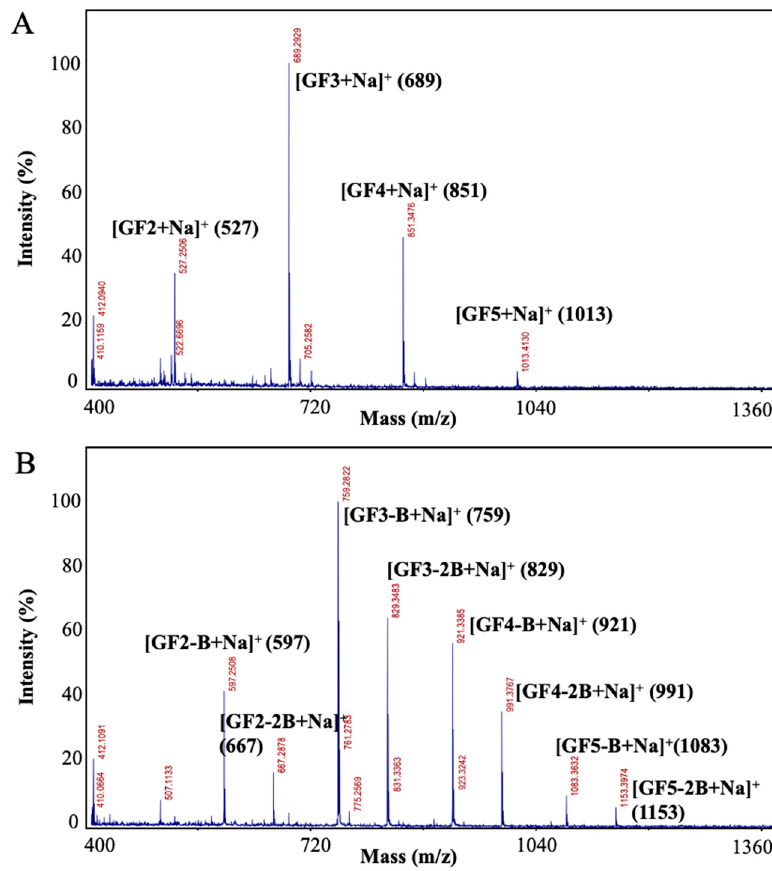
Figure 2. Molecular ion peaks of FOS and B-FOS by matrix-assisted laser desorption/ionization time-of-flight mass spectrometry (MALDI-TOF-MS). The mass spectra were obtained in the m / z range from 400 to 2000. ( A ) FOS; ( B ) B-FOS.